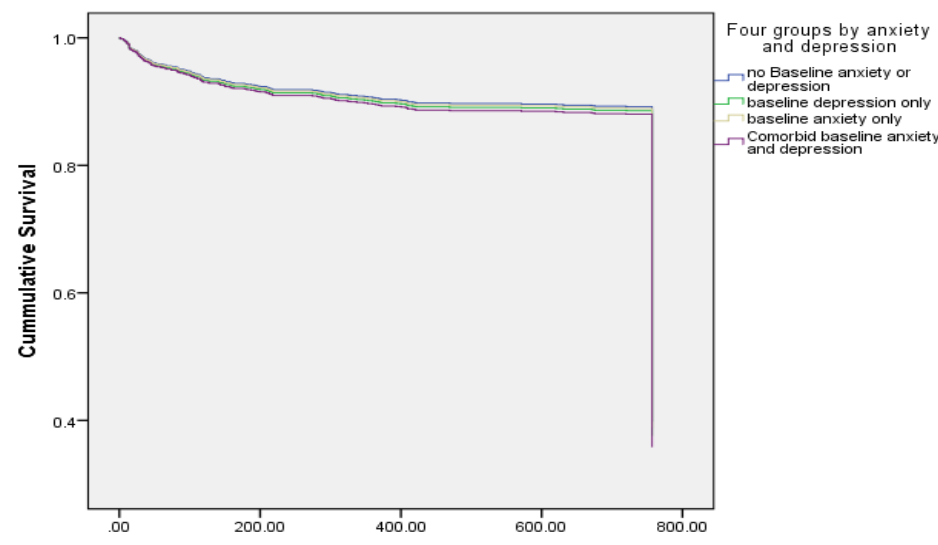
Figure 2. Acute coronary syndrome second event according to comorbid depression and anxiety.